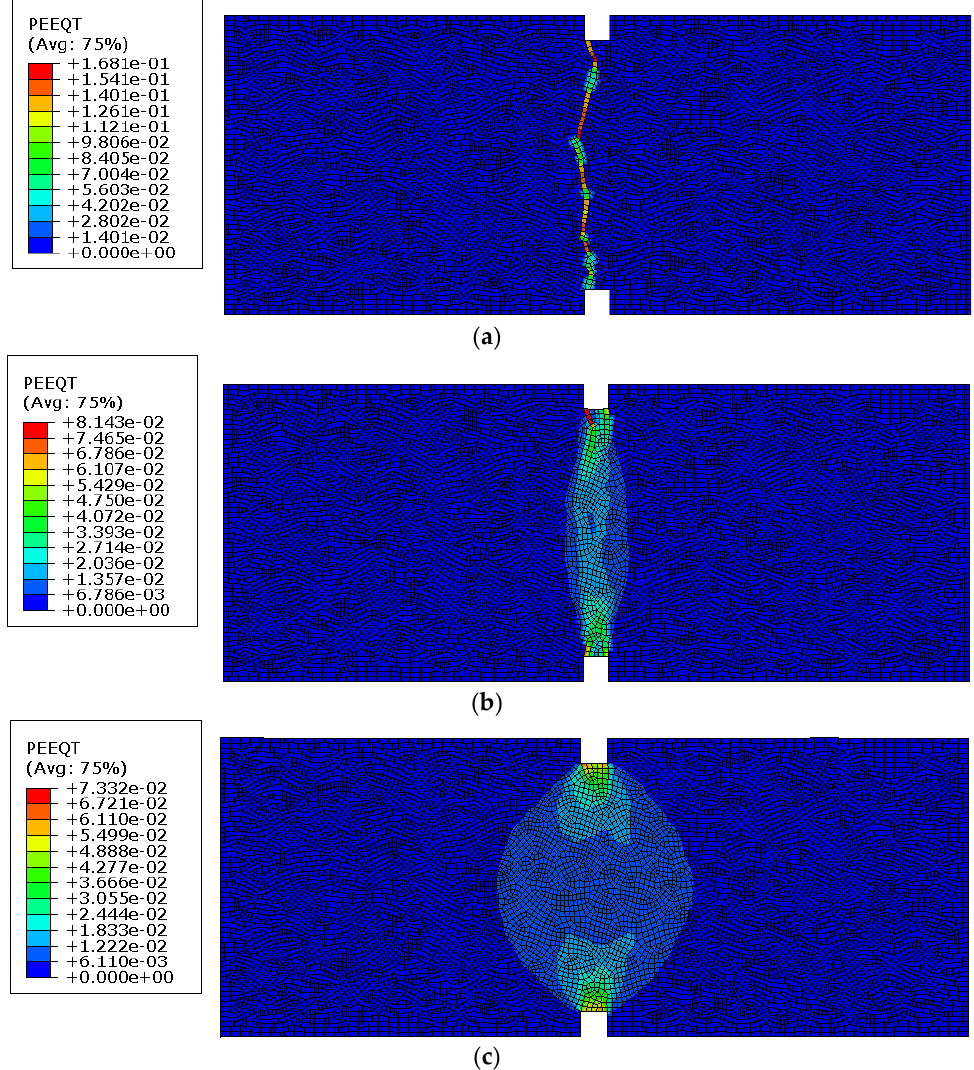
Figure 11. ( a ) Crack pattern, relaxation time equal to 0. ( b ) Crack pattern, relaxation time equal to 0.0001 s. ( c ) Crack pattern, relaxation time equal to 0.001 s.